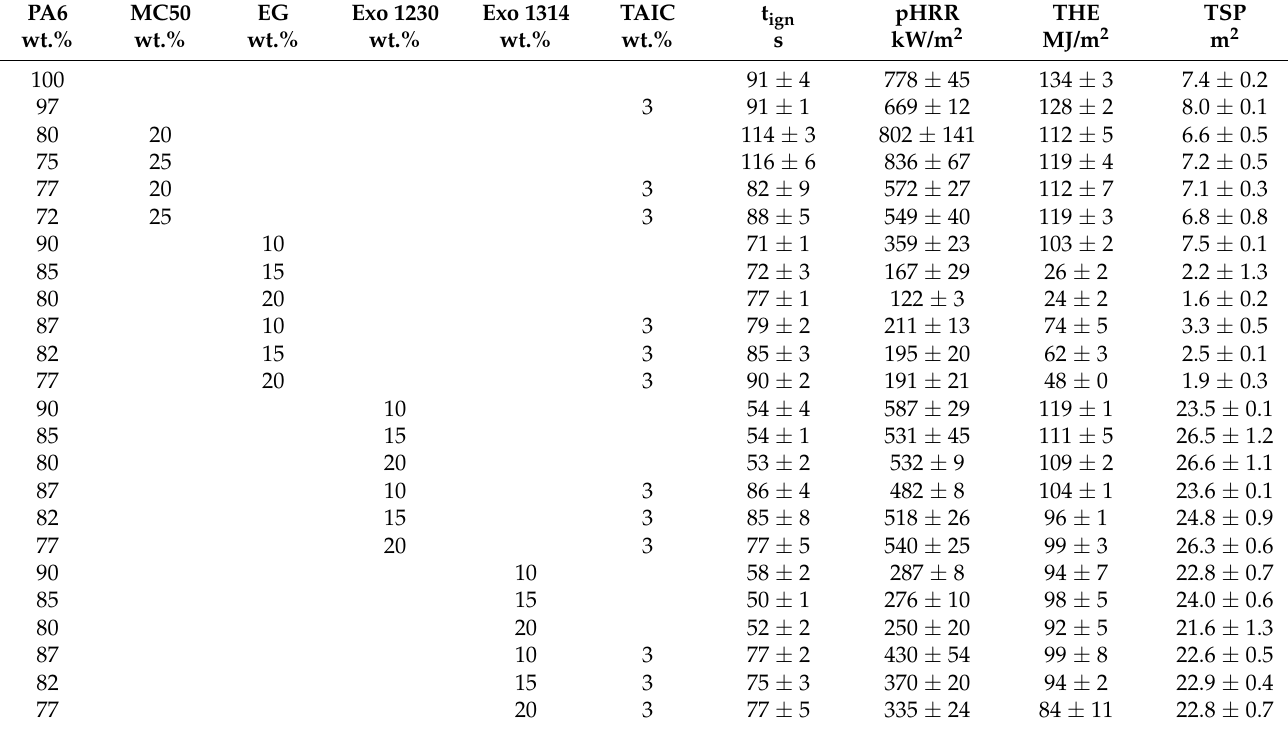
Table 3. Cone calorimeter results measured at an external heat flux of 50 kW/m 2